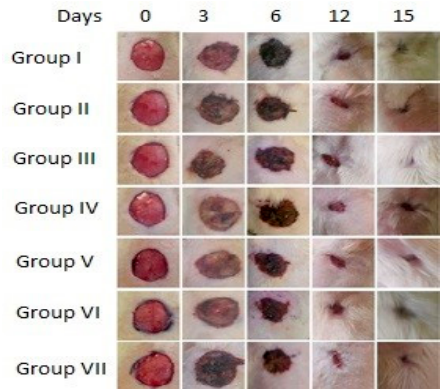
Figure 1. Photography of oil applied on the created wound area on 0, 3, 6, 12 and 15 days after wound